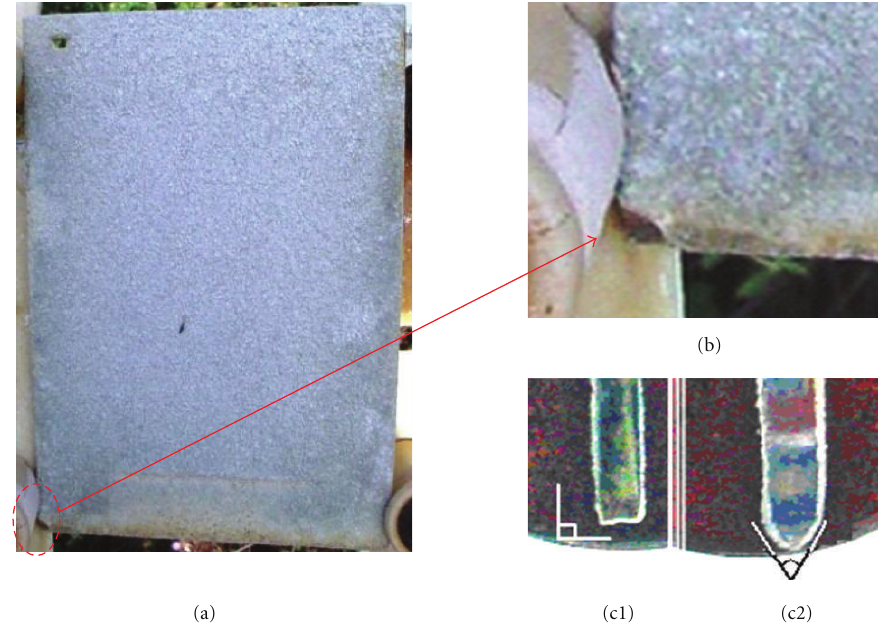
Figure 3: (a) Thermal-sprayed coating of Zn/Al, Thickness = 445 μ m. (b) Details of the edge flaw in the lower border. (c) Transversal cutting: details of the edge of the sample applied by the flame process (90 ◦ angle (c1) and acute (c2)), sample applied by electrical